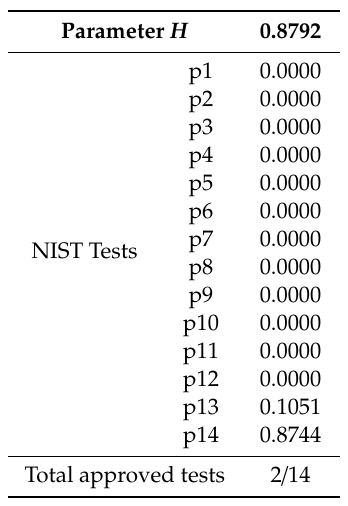
Table 6. Results of the NIST tests for the synthesis of data with the β -MWM algorithm and its Hurst